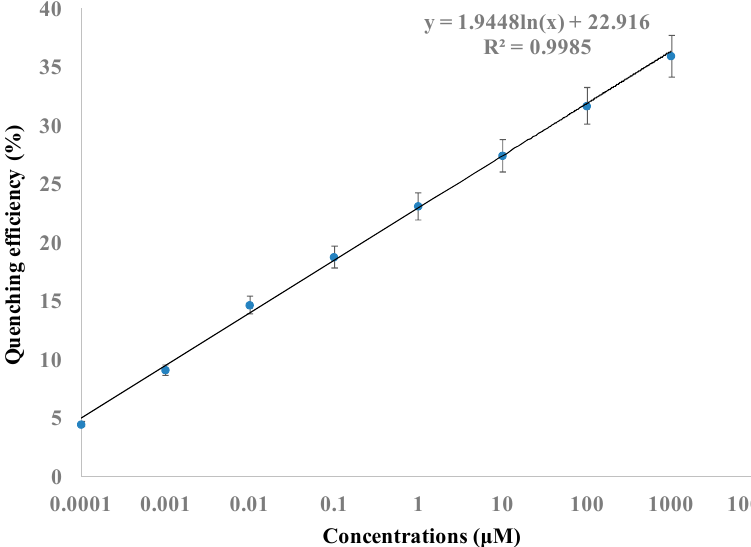
Figure 4. Linear relationship between quenching efficiency versus logarithmic concentrations of histamine.